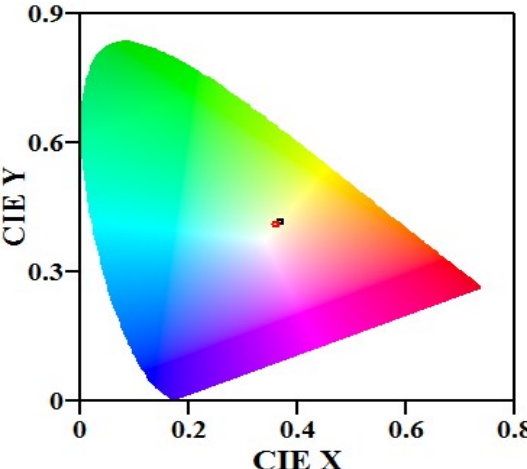
Figure 9. Color coordinates for a 7-layer Bragg stack built from dense Nb 2 O 5 films and a mesoporous one templated with Pluronic PE6200 before (black dot) and during (red dot) exposure to acetone vapors.